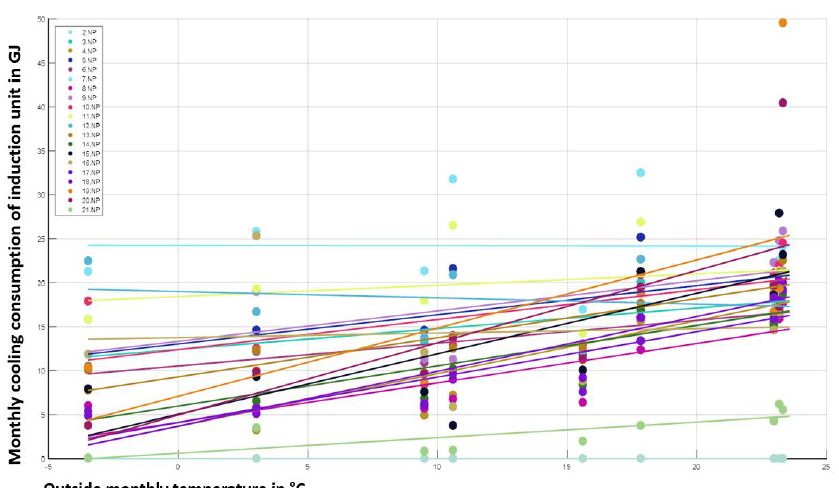
Figure 4: Monthly consumption of cooling for every floor in connection to average outside temperature. (Source: authors with the use of